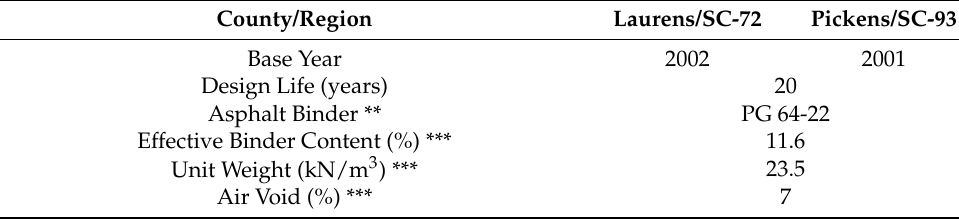
Table 3. Summary of material inputs for AASHTOWare PMED